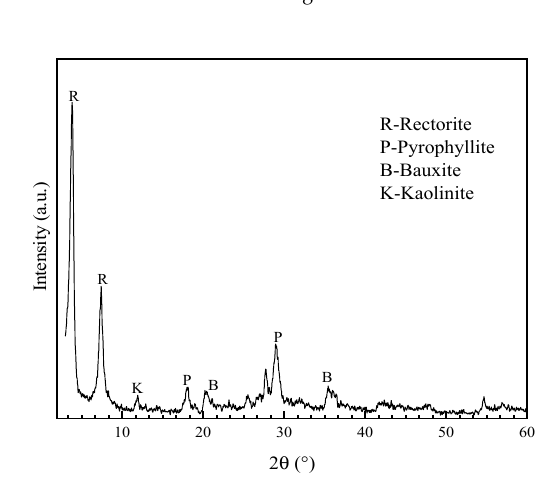
Figure 1. XRD pattern of the purified rectorite.